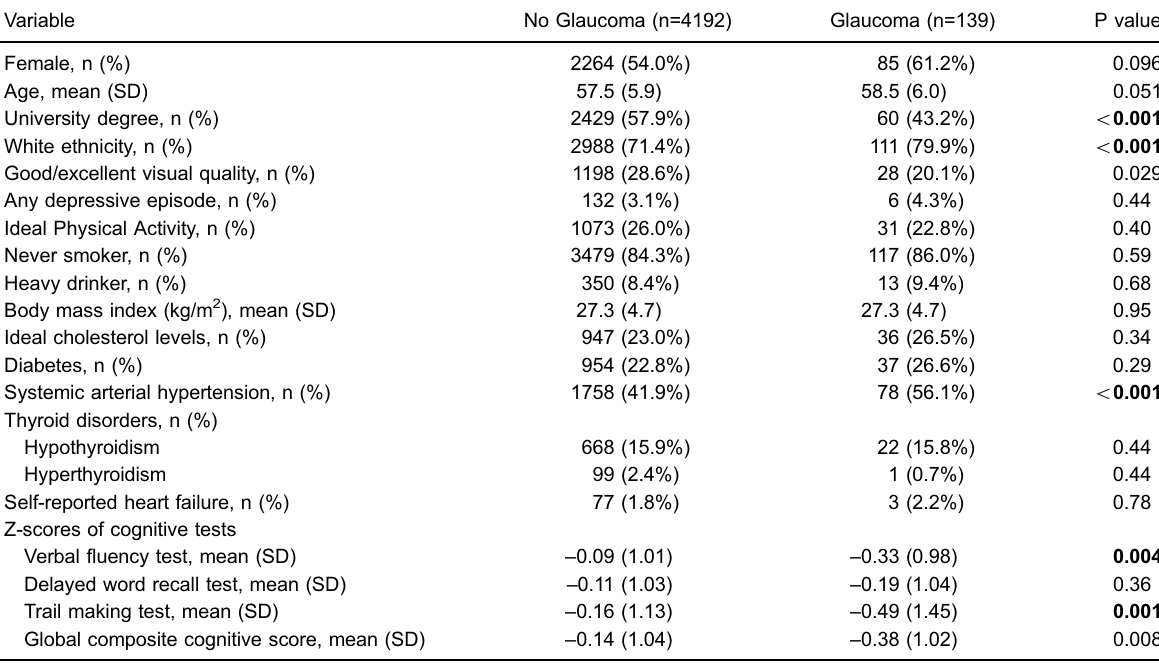
Table 1. Clinical and demographic characteristics of the sample (n=4,331) according to the presence of glaucoma (wave 1 - baseline - of ELSA-Brasil, 2008 –